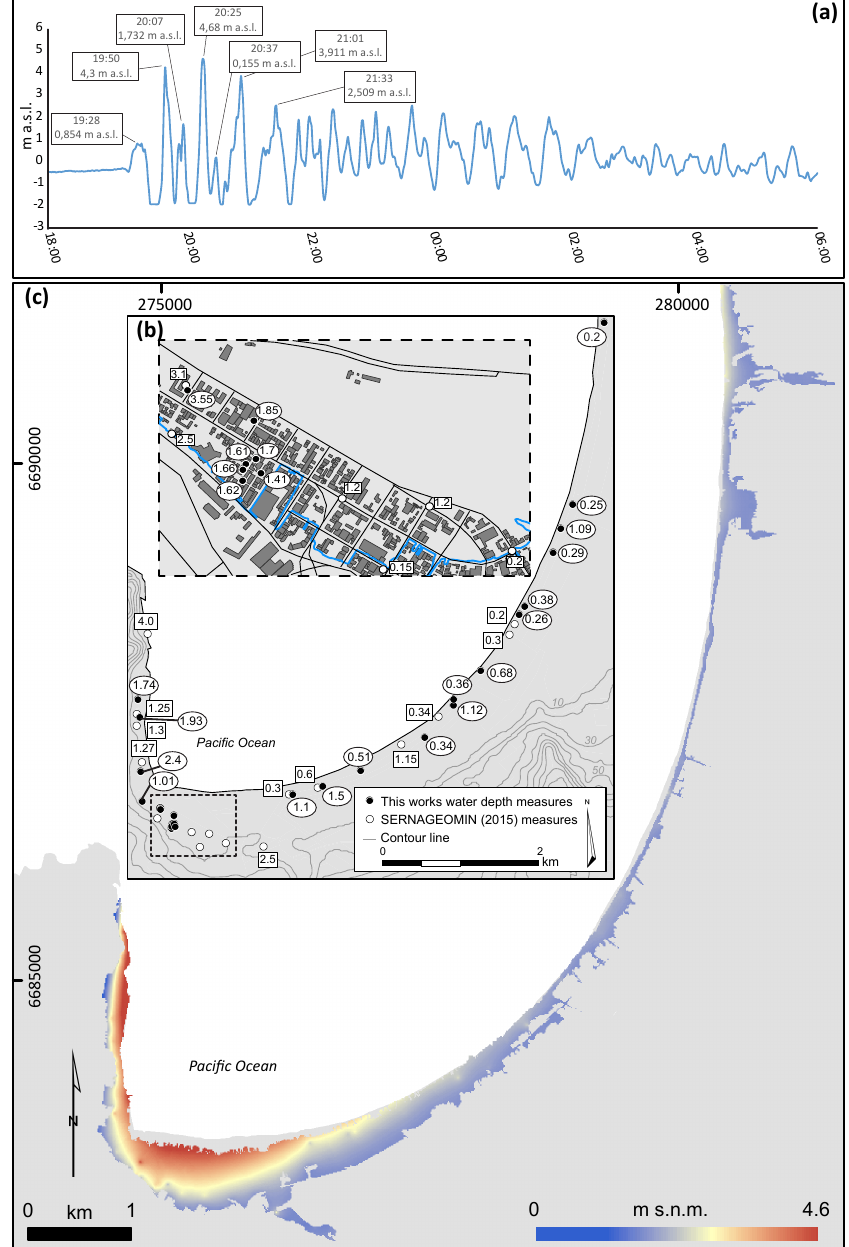
Figure 2. (a) Coquimbo tide gauge measurements (SHOA). (b) Flow depth measurements along Coquimbo and La Serena; the blue line marks the limit of the flood. (c) Reconstructed tsunami inundation map and flow depths from the data collected in the field.